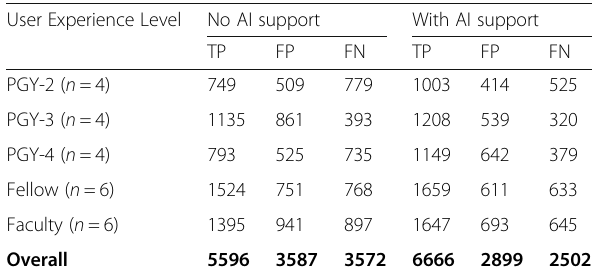
Table 3 True positive (TP), false positive (FP), and false negative (FN) values for mitotic cell detection User Experience Level